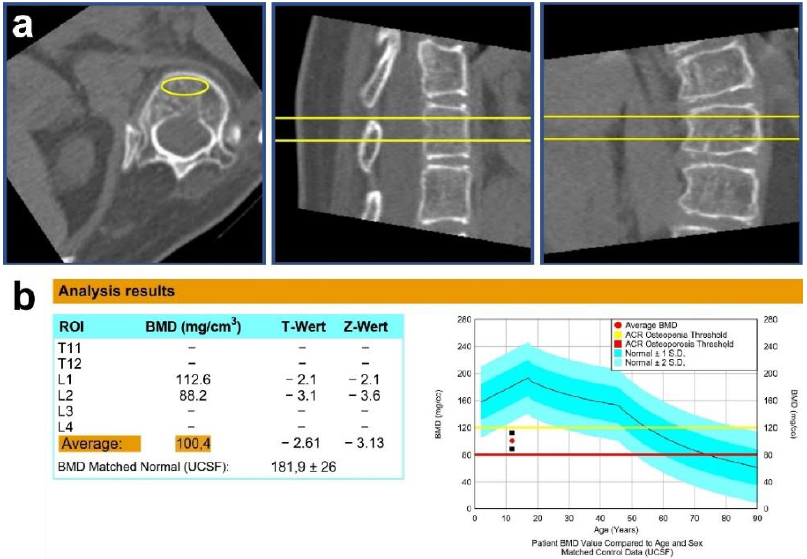
Figure 2. ( a ) The yellow marked region demonstrates the ROI (region of interest) in all three anatomical planes. Cortical bone and neurovascular tissue should not be inside this defined volume. ( b ) The vBMD results with age and sex matched Z-scores based on reference database of UCSF (University of California, San Francisco, CA, USA) [13–17]. The black squares represent the vBMD value of each vertebra and the red dot the average